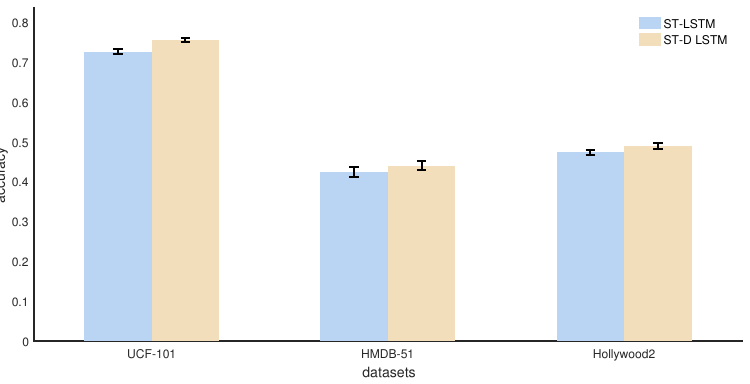
Figure 7. The comparison of accuracy and standard deviation between the ST-LSTM and ST-D